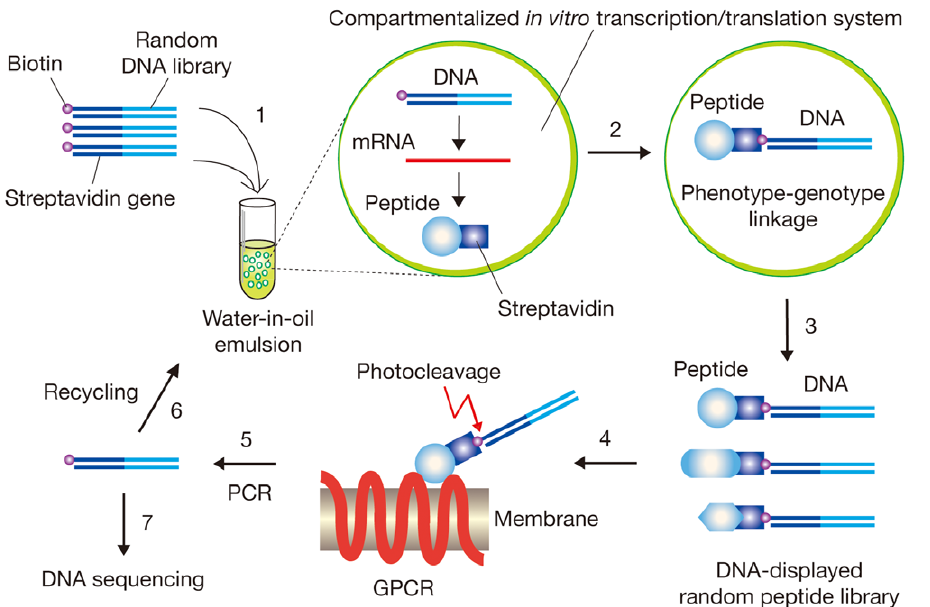
Figure 1. Schematic representation of DNA display selection of peptide ligands for GPCR expressed on cells. A streptavidin gene-fused random DNA library labeled with biotin through a photocleavable linker is introduced into an in vitro transcription/translation system (Step 1 ). A single DNA molecule compartmentalized in a reversed micelle of water-in-oil emulsions is transcribed and translated in vitro (Step 2 ). In each compartment, a translated streptavidin-fused peptide (phenotype) binds to its encoding DNA (genotype) via the biotin label, and a mixture of DNA- peptide conjugates is recovered from the emulsions (Step 3 ). The resulting DNA-displayed random peptide library is affinity-selected with GPCR- expressing mammalian cells, and the DNA portion of binding molecules is eluted by photocleavage (Step 4 ). The selected DNA is amplified by PCR (Step 5 ) and used for the next round of enrichment (Step 6 ) or cloning and sequencing (Step 7 ).